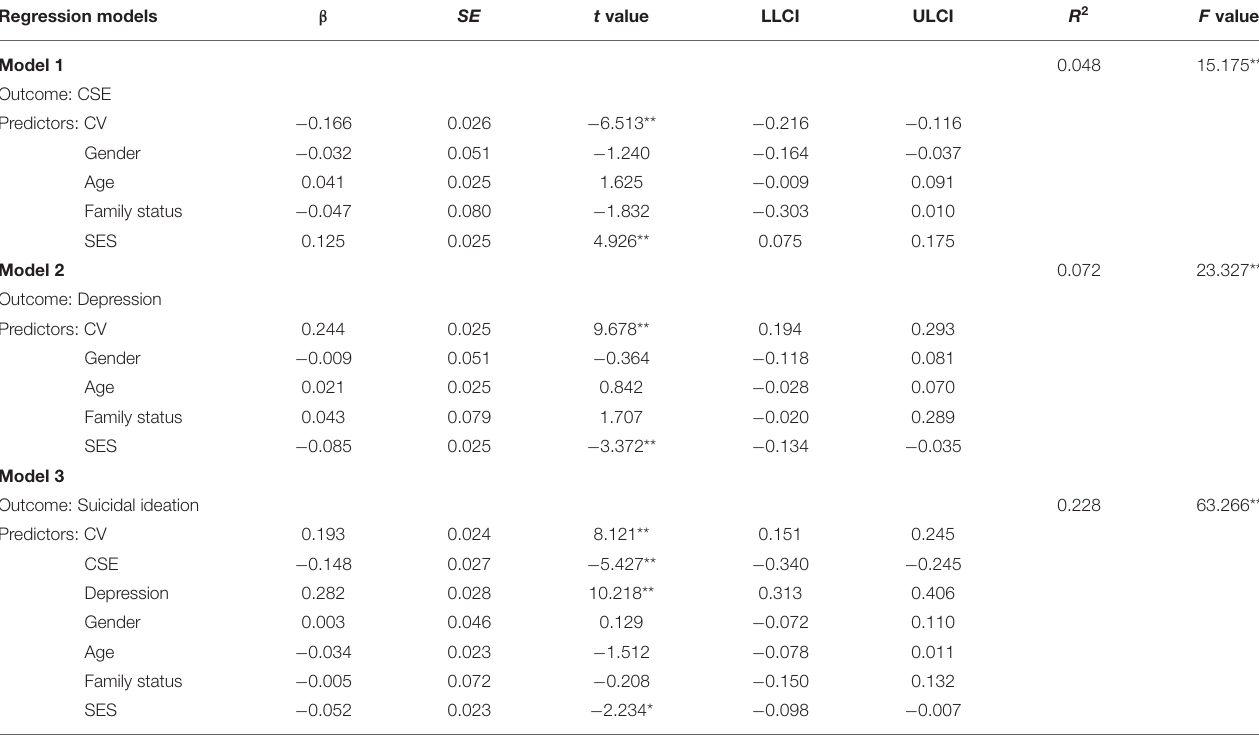
TABLE 2 | Regressions testing core self-evaluation and depression as parallel mediators in the relationship between cyberbullying victimization and suicidal ideation. Regression models